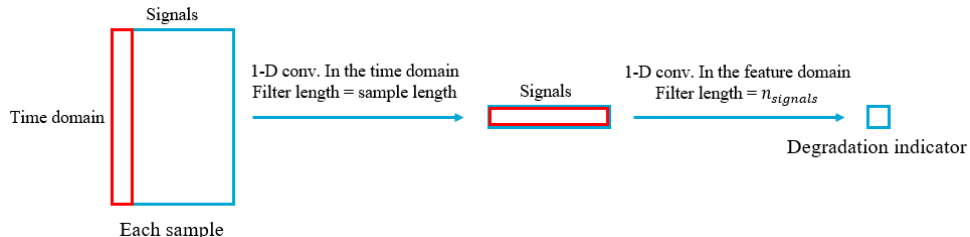
Figure 4. Architecture of the Encoder of the CAE. The Decoder is